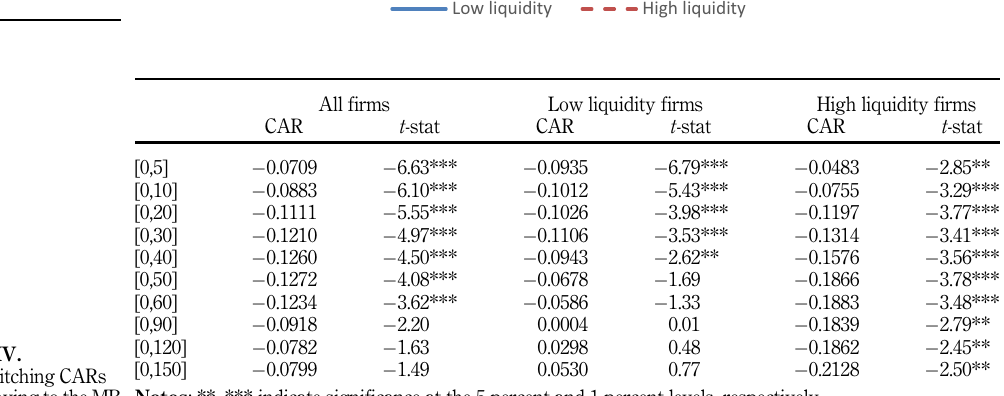
Figure 3. The post-switching CARs: Low liquidity firms versus High liquidity firms